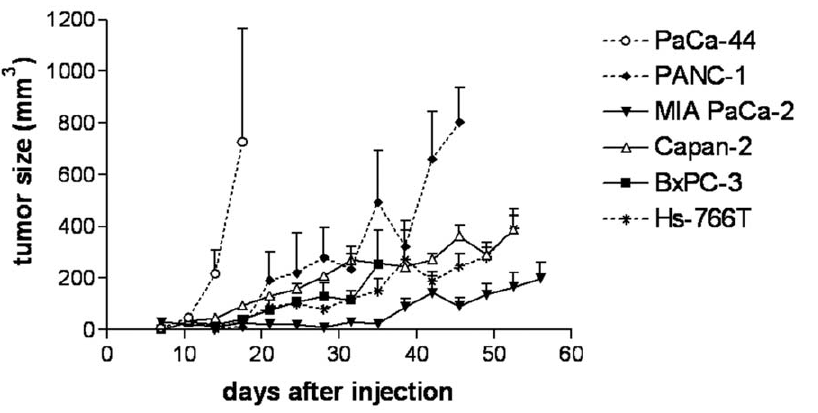
Figure 1. Tumor growth development of subcutaneously growing tumors. 5 6 10 6 cells of each pancreatic cell line were subcutaneously injected into the left flank of C.B-17/IcrHsd- Prkcd scid Lyst bg mice at day 0. Visible tumors were measured twice a week with a caliper and size was calculated by the formula ‘‘length 6 width 6 width/2’’.